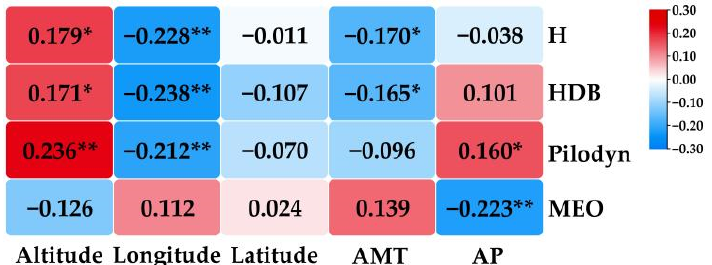
Figure 4. Correlation analysis between growth and wood properties with geographical and climatic characteristics of the 13-year-old C. fargesii clones. AMT, annual mean temperature; AP, annual precipitation. * Represents correlation is significant at the 0.05 level, the same below, and ** represents correlation is significant at the 0.01 level.